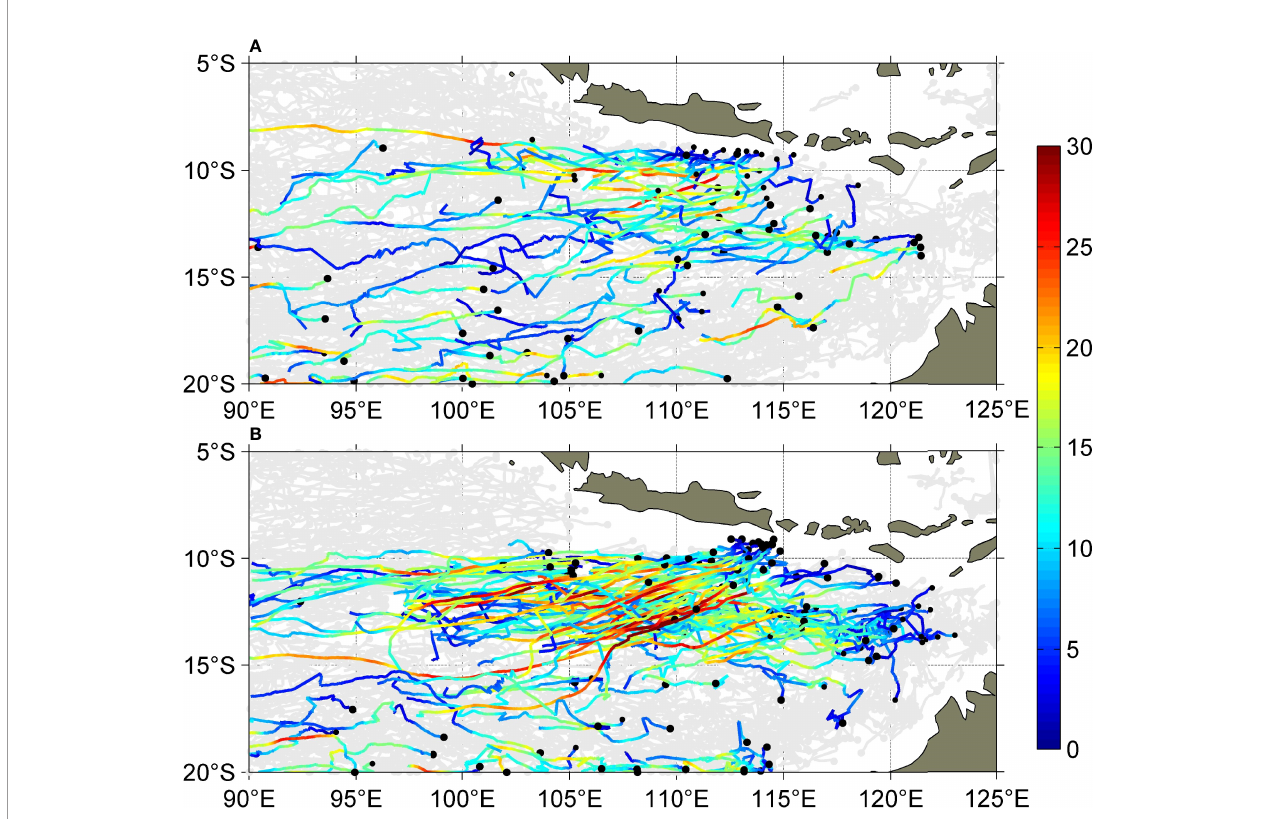
FIGURE 5 | Trajectories of eddies generated in austral summer (A) and austral winter (B) , respectively. The eddies with intensity (unit: cm) smaller than 15 cm are marked by gray curves, whereas the eddies with intensity larger than 15 cm are showed by color curves. The gray and black dots indicate the locations of eddy